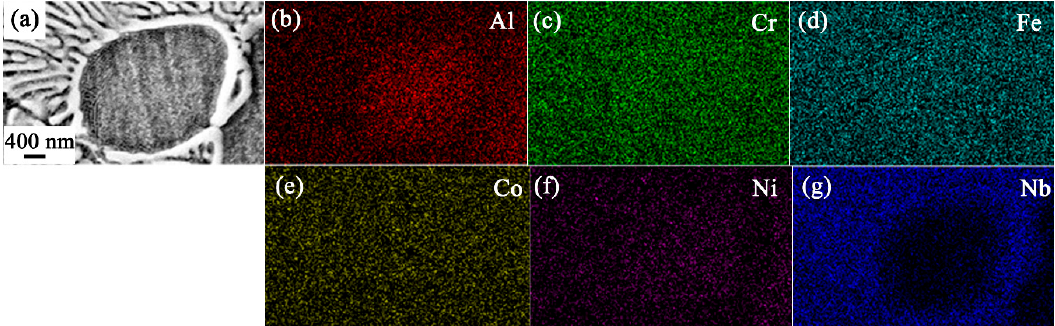
Figure 4. EDS mapping of AlCoCrFeNiNb 0.5 : ( a ) secondary electron image, ( b ) Al, ( c ) Cr, ( d ) Fe, ( e ) Co, ( f ) Ni, ( g ) Nb.